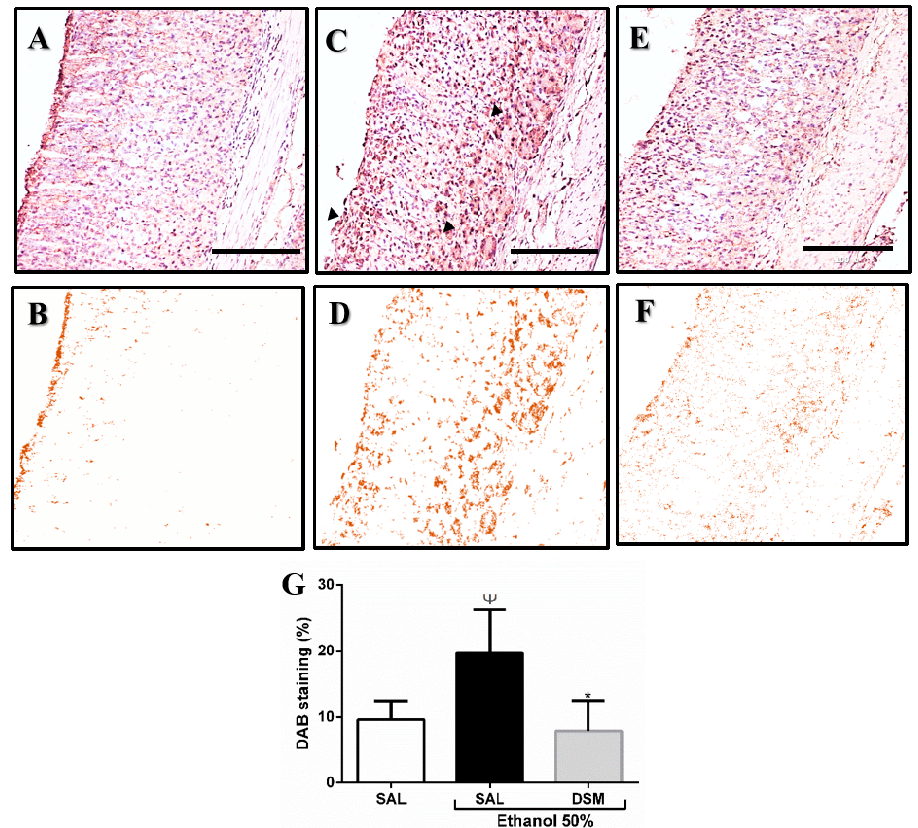
Figure 3. Immunohistochemical analysis of the TRPV1 receptor on the gastric mucosa ( A , C , and E ). Diaminobenzidine (DAB) staining by color deconvolution ( B , D , and F ). A and B : TRPV1 immunoreactivity detected in normal gastric mucosa. C and D : Increased immunoreactivity of TRPV1 in the ethanol-injured group. E and F : Decreased immunoreactivity in gastric mucosa of animals pretreated with DSM for 3 days before ethanol-induced gastric damage. G : Color deconvolution analysis of DAB staining for TRPV1 in gastric mucosa. One-way analysis of variance followed by a Newman – Keuls post hoc test. Ψ p < 0.05 versus healthy group; * p < 0.01 versus injured group. The arrows indicate the increase of marking intensity. Photomicrographs (100×, scale 100 μ m).